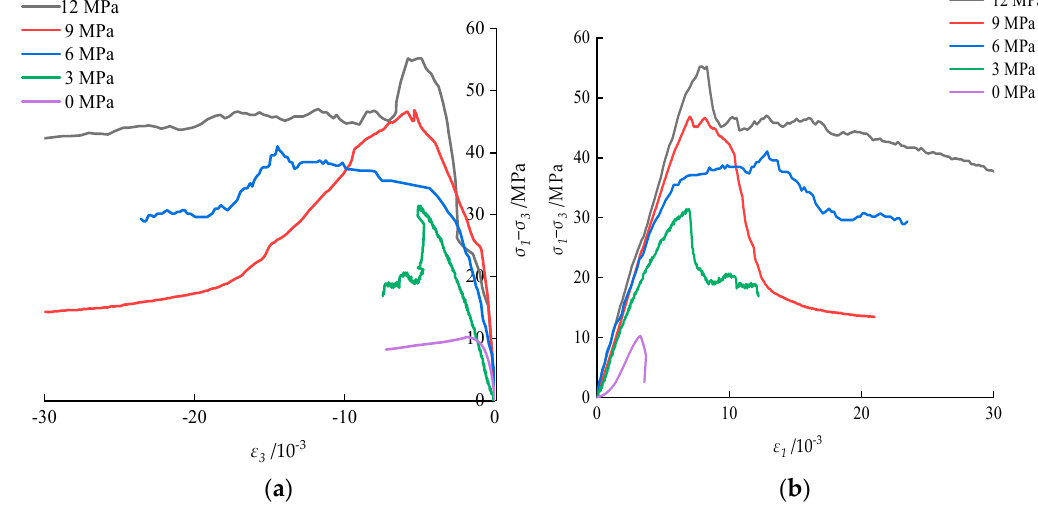
Figure 5. The variation between deviatoric stress and strain of samples with 0° under different confining pressures. ( a ) radial strain ( ε 3 ). ( b ) axial strain ( ε 1 ).